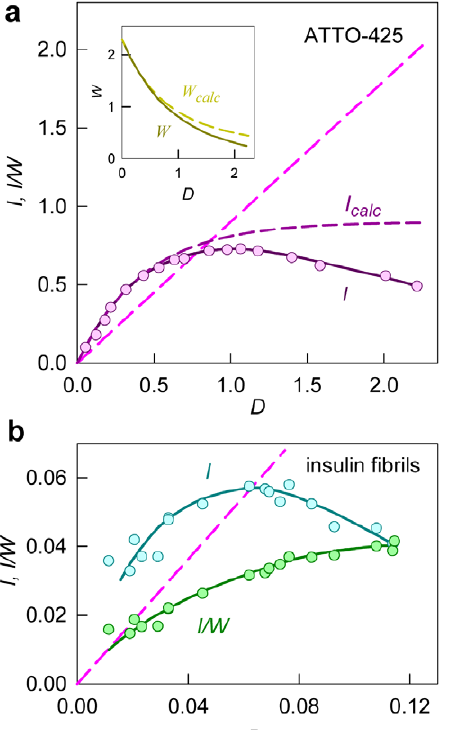
Figure 4. The dependence of fluorescence intensity on optical density of fluorophore and on total optical density of solution. ( a ) The dependences of fluorescence intensity on optical density ( D ATTO ) of the fluorescence dye ATTO-425 with known quantum yield ( q ATTO =0.9) calculated from equation (15) and experimentally recorded I . The dependence of fluorescence intensity on the optical density of